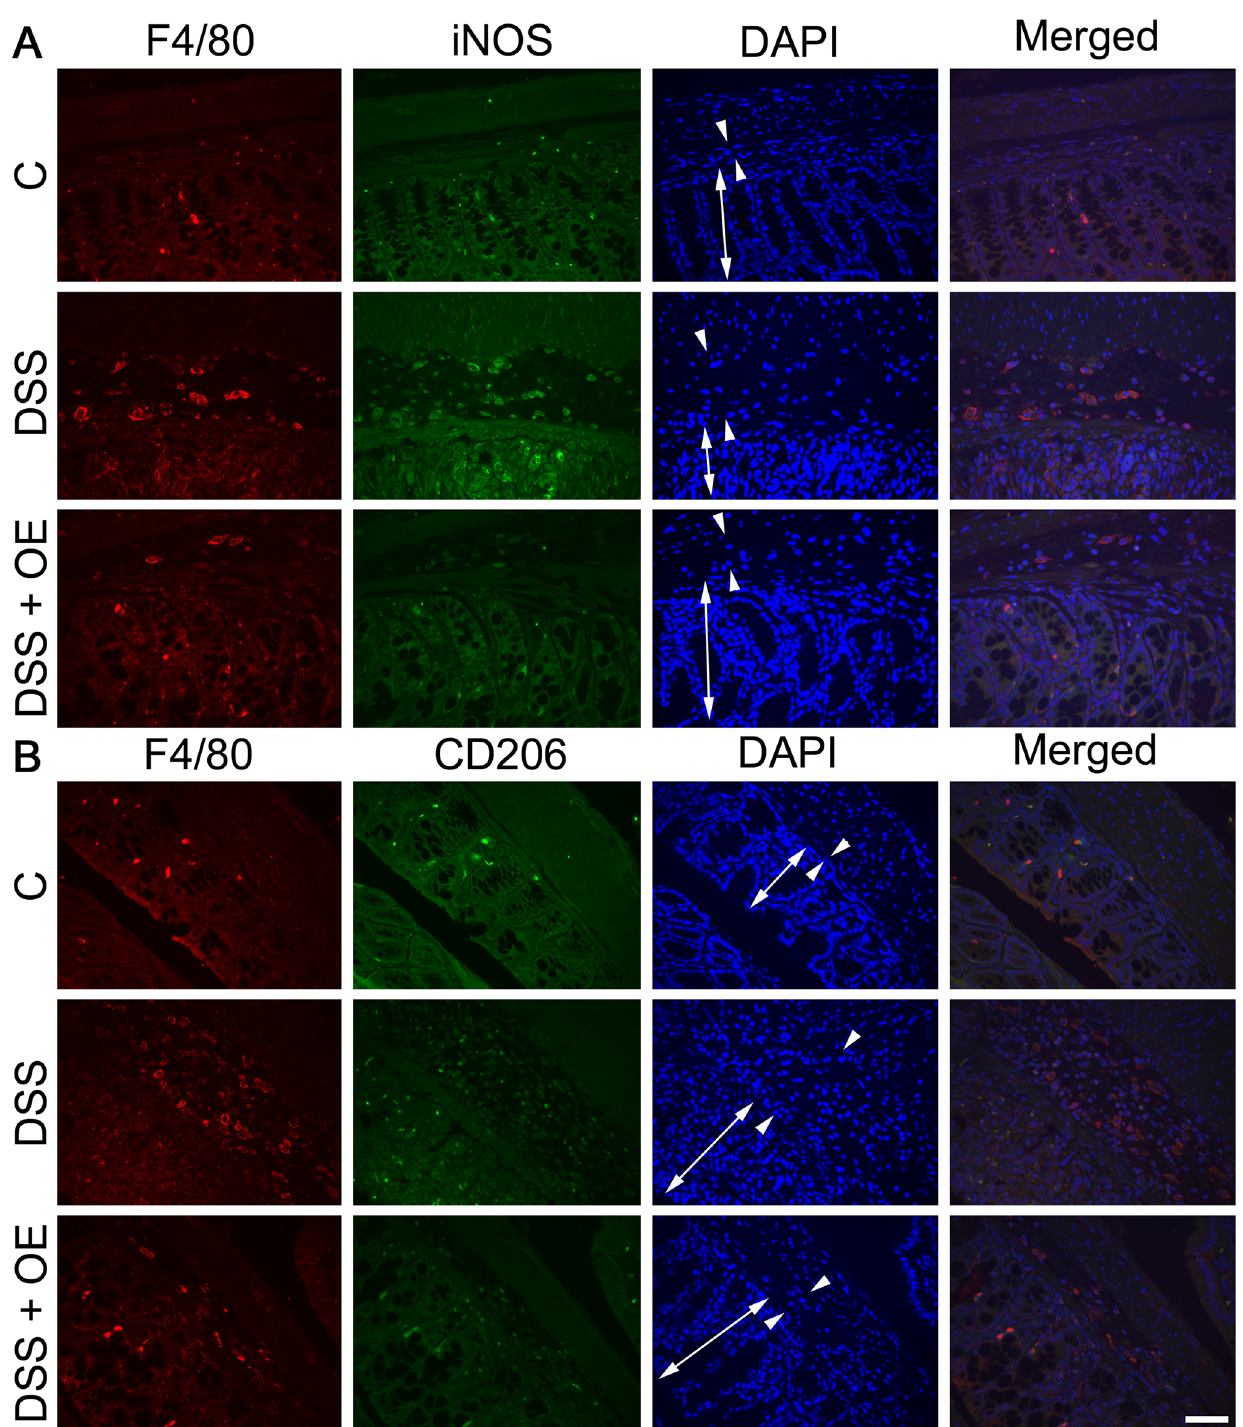
Fig 8. Effect of enoxaparin on macrophage phenotypes. Co-immunostaining of macrophages and their phenotypes. Representative images of (A) M1 macrophages (F4/80 + and iNOS + ) and (B) M2 macrophages (F4/80 + and CD206 + ) using colon tissue from n = 3 – 5 mice. F4/80 positive cells were visualized using Alexa Fluor 594-conjugated goat anti-rat IgG (red) and iNOS or CD206 positive cells using Alexa Fluor 488-conjugated goat anti-rabbit IgG (green). Nuclei were stained with 4 ’ ,6-diamidino-2-phenylindole (DAPI, blue). Localization of mucosa (double-headed arrow) and submucosa (arrowheads) is indicated. Scale bar = 50 μ m for 400 × magnification. Control, C; untreated colitis, DSS; colitis with oral enoxaparin, DSS+OE.